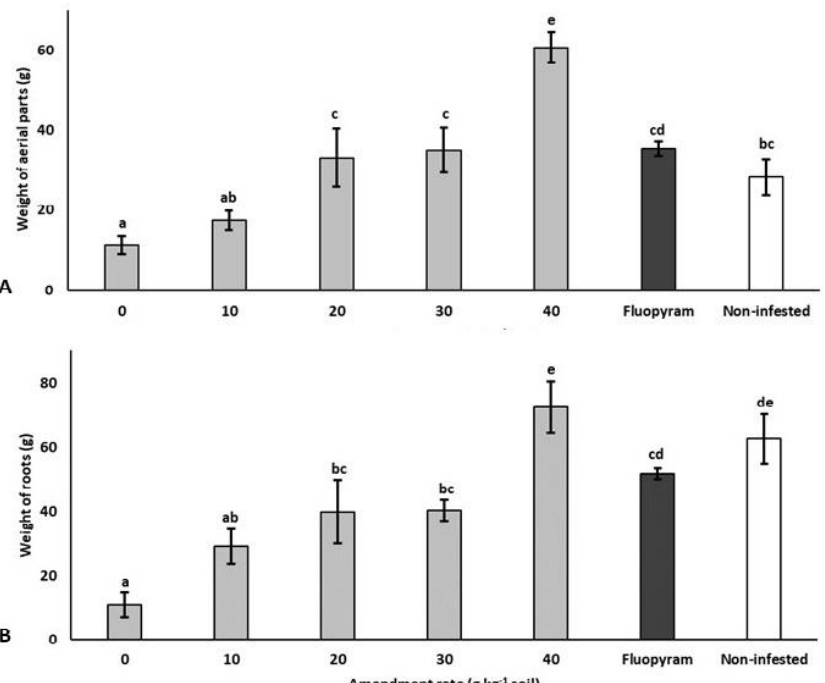
Figure 3. Effect of soil amendments with 10–40 g kg − 1 soil rates of dry biomass of Hedysarum coronarium and Fluopyram (0.625 L ha − 1 ) on the growth of the aerial parts ( A ) and roots ( B ) of tomato plants in soil infested by Meloidogyne incognita . The values are the averages of five replicates. Bars marked with the same letter are not significantly different according to the LSD test ( p < 0.05).